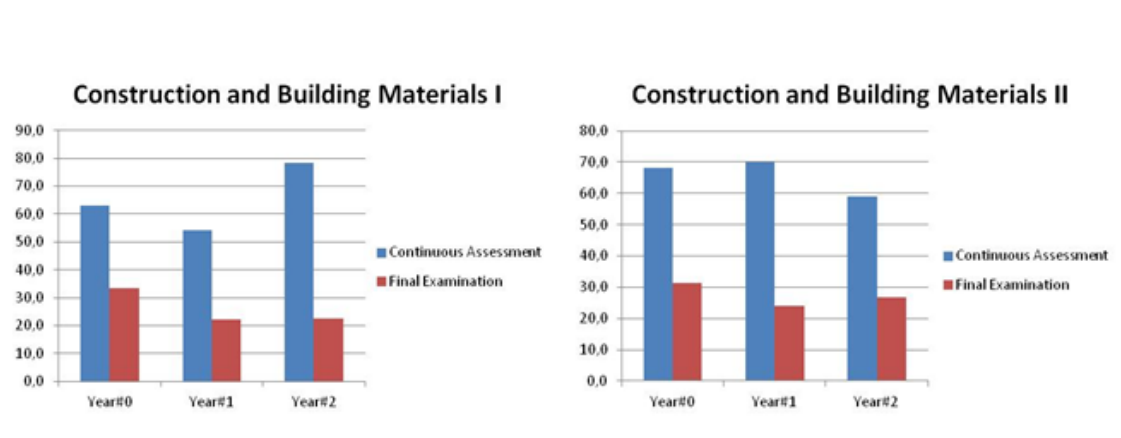
Figure 8. Percentage of students that pass the subject each academic year of a three-year